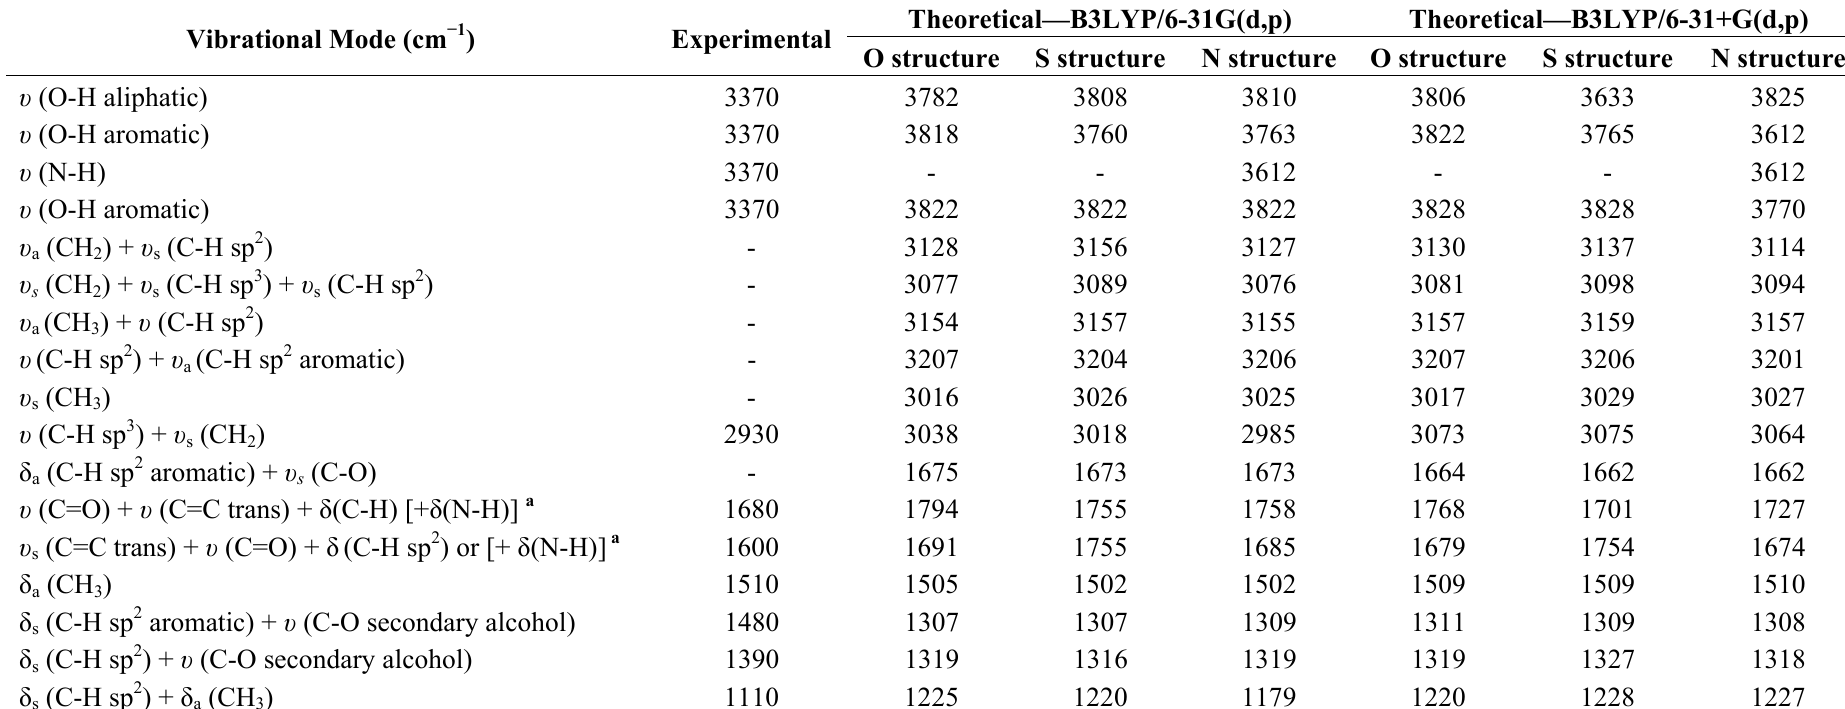
Table 5. Experimental and theoretical attribution of absorption bands in the IR (in cm − 1 ) calculated at the B3LYP/6-31G(d,p) level for the heterologous